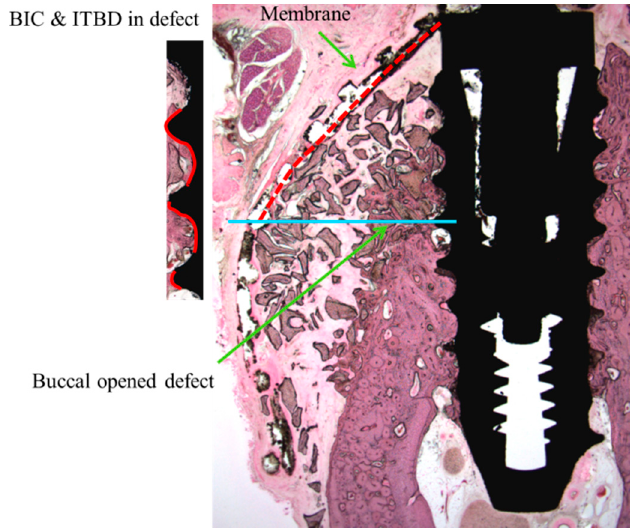
Figure 4. Measurements made using histologic specimens were: new bone volume in the opened buccal defect region (NB, in the space surrounding a buccal open defect, implant, and membrane, %); bone-to-implant contact ratios in the upper third thread portion of the implant in the opened buccal defect region (BIC, red line, %); and intra-thread bone density in the upper third of the threaded implant portion in the opened buccal defect region (ITBD, %). Blue line: inferior border of open buccal defect.